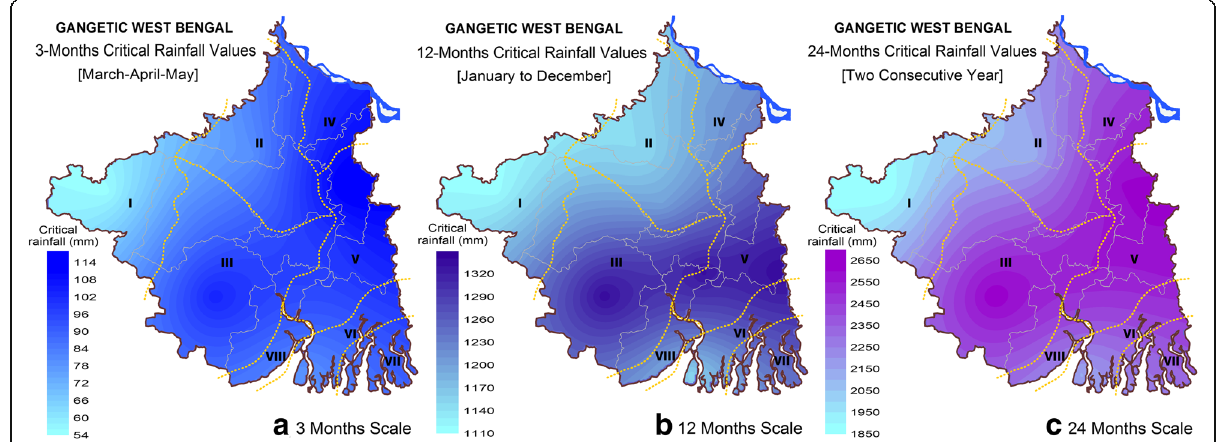
Fig. 16 Critical rainfall values for ( a ) 3-months ( b ) 12-months ( c ) 24-months time